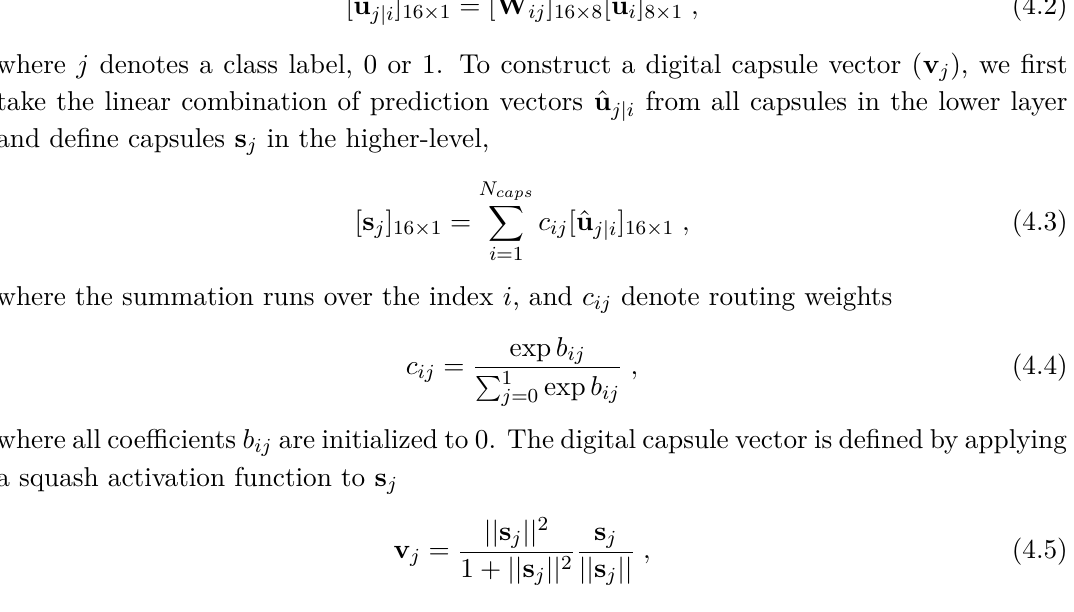
relations between the pixels at higher and lower levels. A capsule neural network (Cap- sNet) [95, 96] was proposed to address the potential problems of the CNN, and figure 7 shows the schematic architecture of the CapsNet used in our